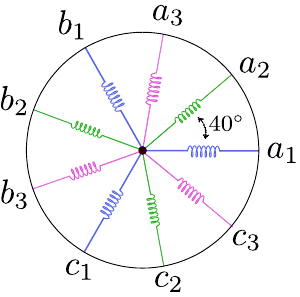
Figure 1. Symmetrical representation of a nine-phase motor with 40 ◦ electrical displacement between three-phase